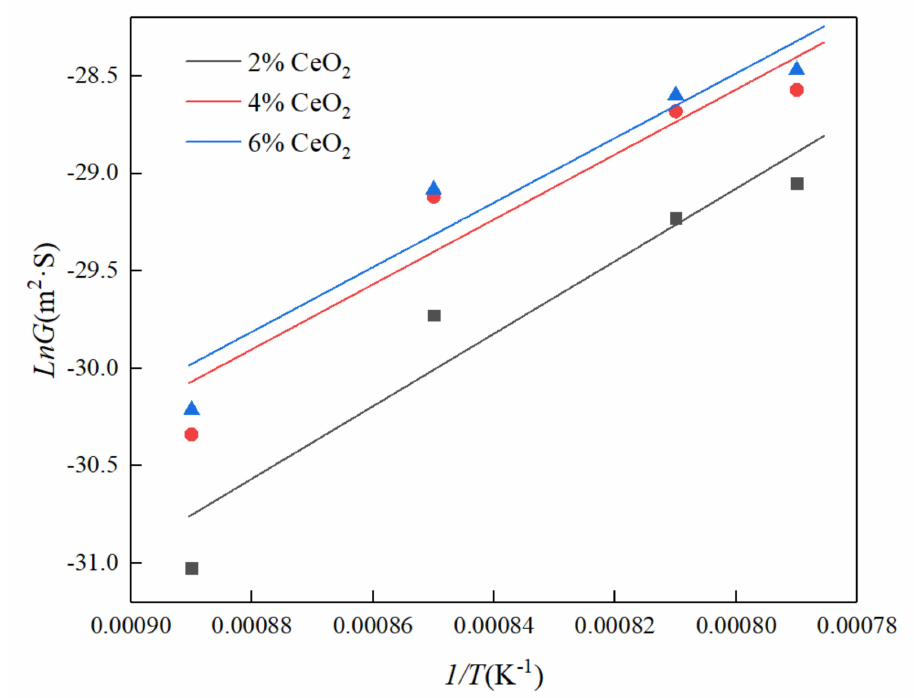
Figure 3. Relationship between Ln G and 1/ T under different rare earth contents (straight